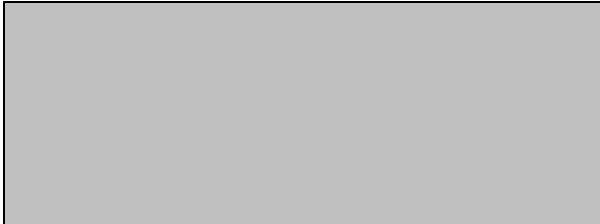
Table IV : Specific gravity of urine [median